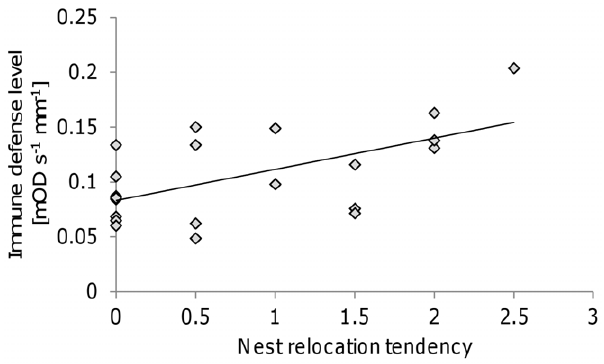
Figure 5. The positive relationship between the nest relocation tendency and the immune defense level, corrected for body size (head width of individual ants). The trend line is the best-fitted line according to a linear regression test.